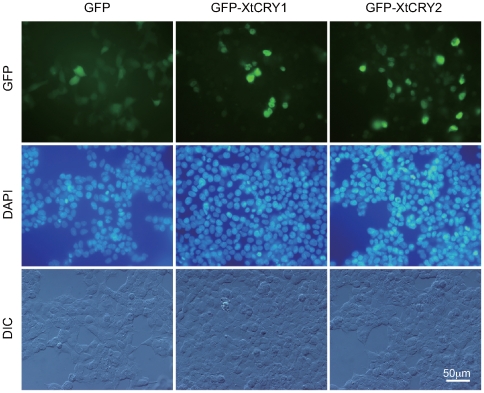
Cellular localization of GFP-fused XtCRYs in HEK 293 cells.Each expression vector was transfected and observed using a fluorescence microscope (upper, GFP; middle, DAPI) or differential interference microscope (lower, DIC).